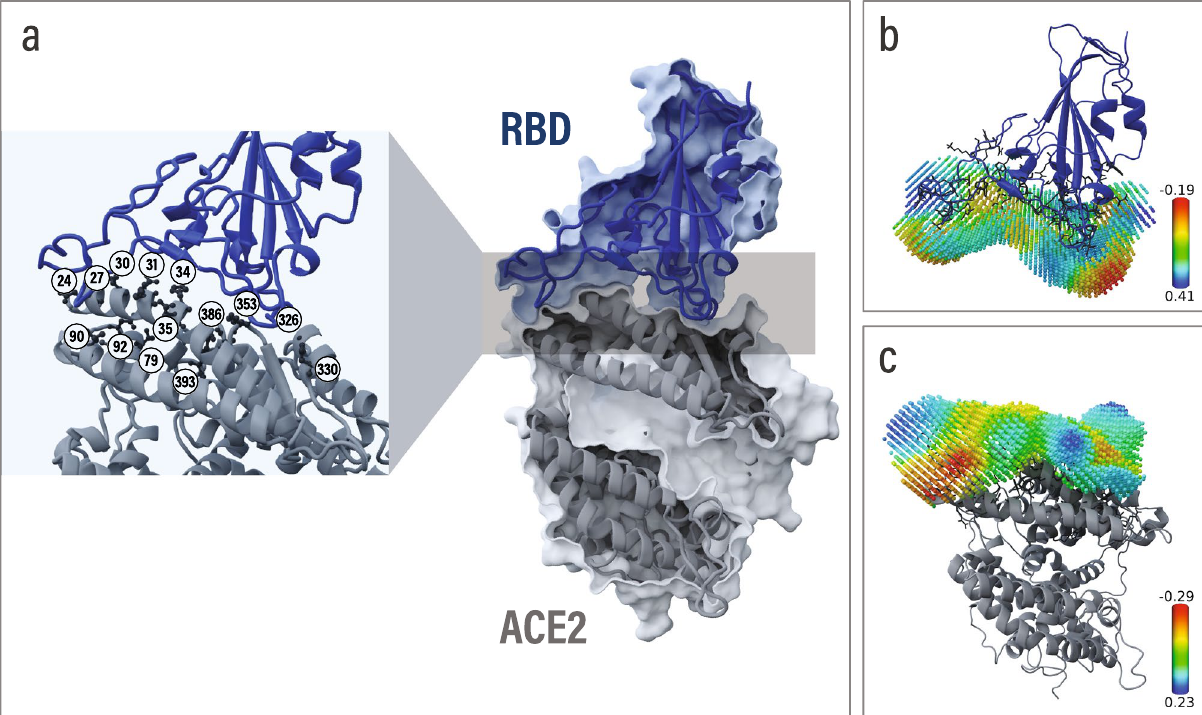
Figure 3. The binding interface between SARS-CoV-2 spike RBD, shown in dark blue, and hACE2, visualized in gray (PDB: 6M0J). ( a ) Selection of hACE2 mutations from MD simulations and binding affinity assays are shown as sticks. Mutated amino acids are labeled according to their position in the hACE2 protein chain. ( b ) SARS-CoV-2 spike RBD and spike RBD Hydrophobicity Halo. ( c ) hACE2 and hACE2 Hydrophobicity